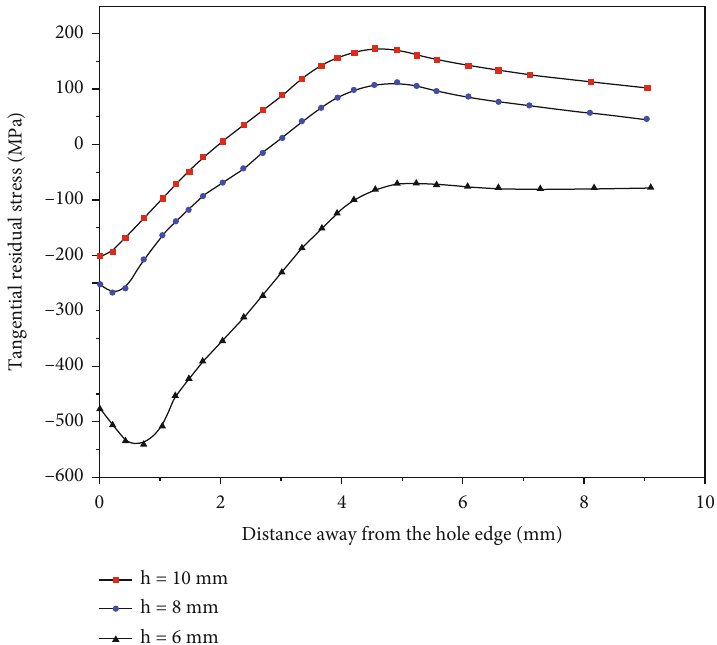
Figure 9: Changes of tangential residual stress under di ff erent substrate